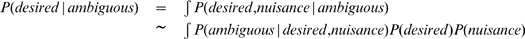
Bayesian inference: from discounting to explaining-away.Perception is characterized by two complementary processes: 1.) The “generative process” determines how scene properties, such as an object's physical size and distance, cause the observer's sensations, such as monocular image cues, binocular, and haptic information, and 2.) The scene “inference process” characterizes the observer's use of generative and prior knowledge to recover local scene properties. The generative process can be summarized by a conditional likelihood , the inference process by the posterior probability distribution, . Bayes' rule dictates how each process relates: , where  represents the prior probability distribution over scene properties. In the figures above, scene properties are represented by white nodes, and cues are represented by gray nodes. In our experiment, the desired property was the physical ball size, the nuisance property was the physical ball distance, the ambiguous cue was the monocular image size cue, and the auxiliary cue was provided by the binocular and haptic distance cues. A.) Discounting inference: a desired property influences a single cue, which is ambiguous due to the confounding influence of a nuisance property. The single ambiguous cue can be used to estimate the desired scene property that caused it by discounting the effect of the nuisance property using prior knowledge about it. The conditional relationships (arrows) in Box A specify that Bayes' rule can be factored such that:B.) Explaining-away inference: similar structure to discounting, but involves additional, auxiliary cues. By using the auxiliary cue to “explain-away” the influence the nuisance property has on the ambiguous cue, the desired property can be unambiguously inferred. Bayes' rule specifies inferring the desired property as:The ambiguous and auxiliary cues can be factored because they are conditionally independent given the nuisance property.